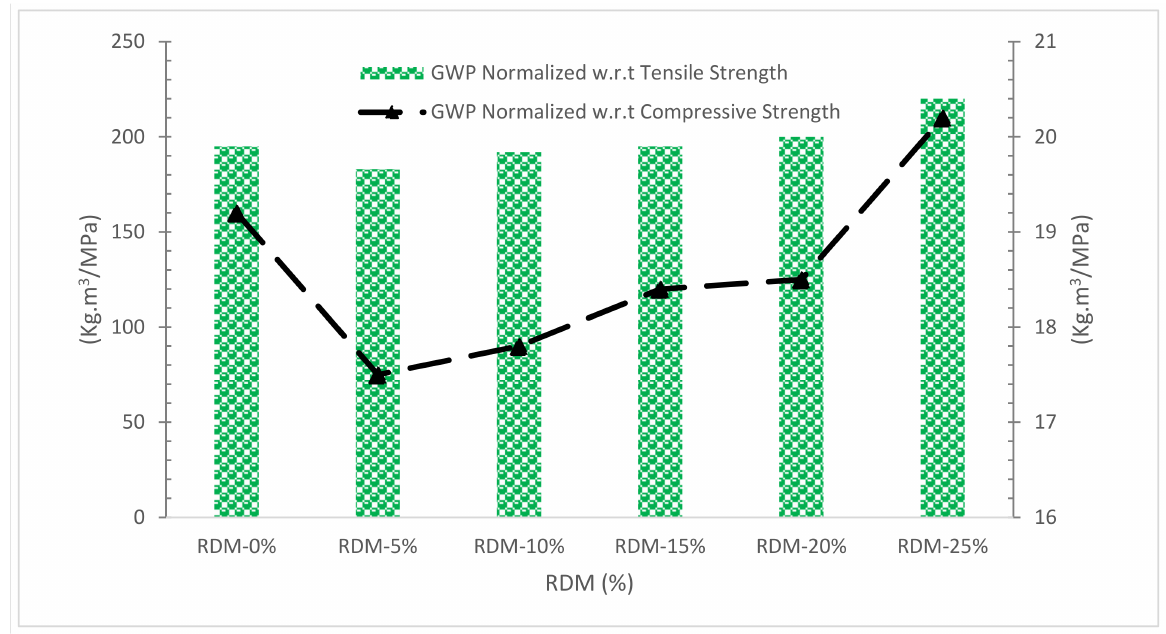
Figure 22. Normalized GWP W.r.t Compressive strength and TS: Data Source